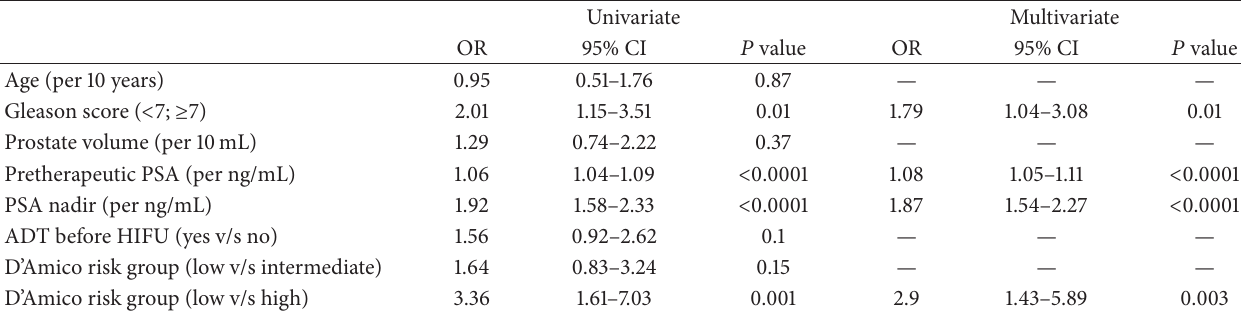
Table 3: Univariate and multivariable analysis of factors affecting biochemical recurrence free survival in 108 patients.